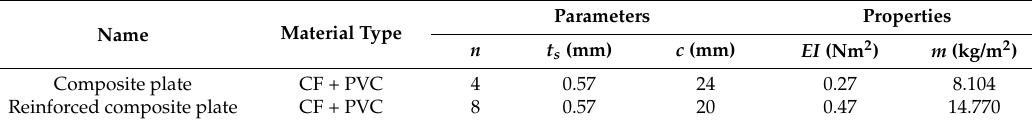
Table 4. Two of the optimal results of the sandwich structure of the